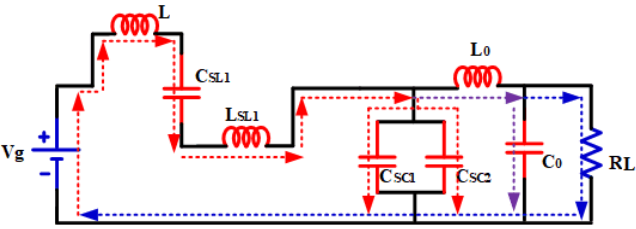
Figure 5. Current flow path of the converter circuit during the interval t off .